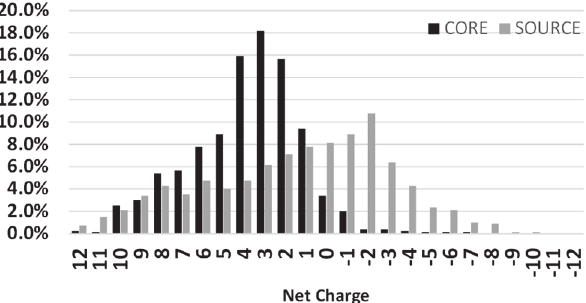
Fig 5. Statistical distribution of the net charge of AMP critical regions and the background. Less than 3% of the AMP critical regions and source proteins (background) having net charge over ± 12 is not shown here.